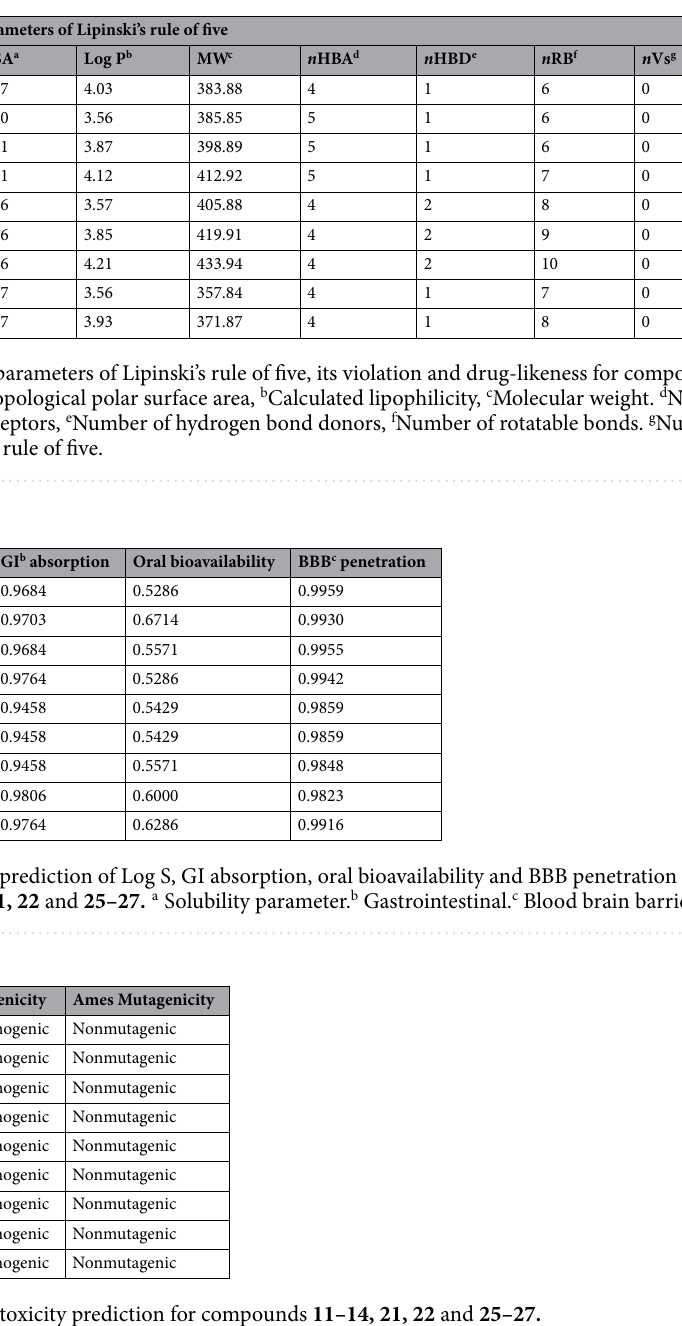
Table 6. AdmetSAR toxicity prediction for compounds 11–14, 21, 22 and 25–27.